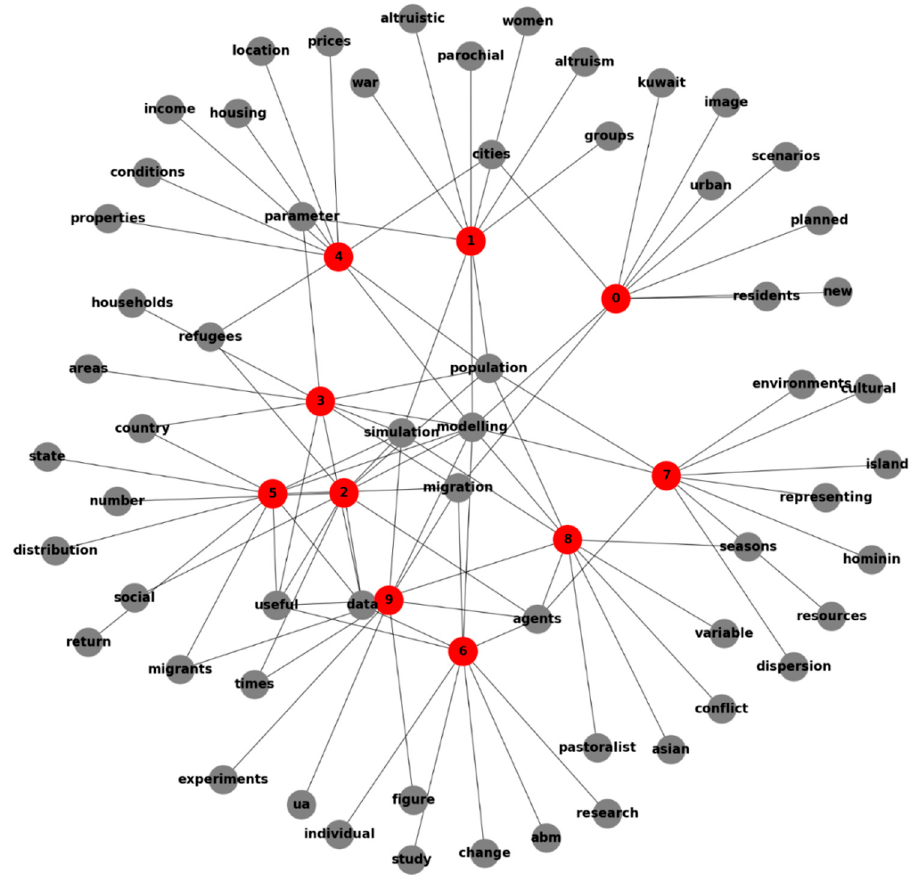
Figure 6. The topic decomposition of the set of articles that we analysed.